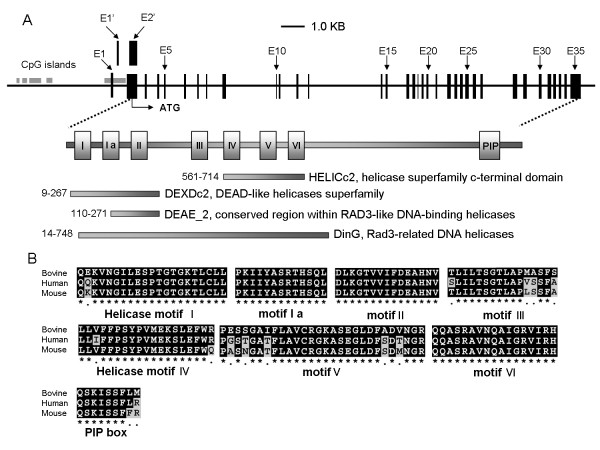
Genomic organization, motif characterization and sequence comparison of bovine RTEL. Bovine RTEL encodes a conserved helicase-like protein. A. Schematic representation of genomic organization and motif characterization of bovine RTEL. The genomic sequence of bovine RTEL is distributed among 35 exons spanning 24.8 kb of genomic DNA. The vertical lines represent exons (only partial exons are numbered); grey lines indicate CpG islands predicted in the putative promoter region. Because two forms of 5'UTR were identified, the exon 1' and exon 2' represent the alternative first and second exons respectively (see alternative splicing section for details). The deduced bovine RTEL protein contains three functional domains (DEXDc2, DEAE_2 and HELICc2) classified into the DinG, Rad3-related DNA helicases. The grey lines and related numbers below the schematic (not to scale) represent the position of each domain. The roman numbers specify seven characterized helicase motifs within the domains, and "PIP" indicates the PIP box identified near the C-terminus of RTEL protein. B. multiple alignments of deduced amino acids sequences in the eight identified motifs among three identified RTEL homologues. The consensus sequences of each motif are shown, identical and similar residues are shaded by black and grey respectively.